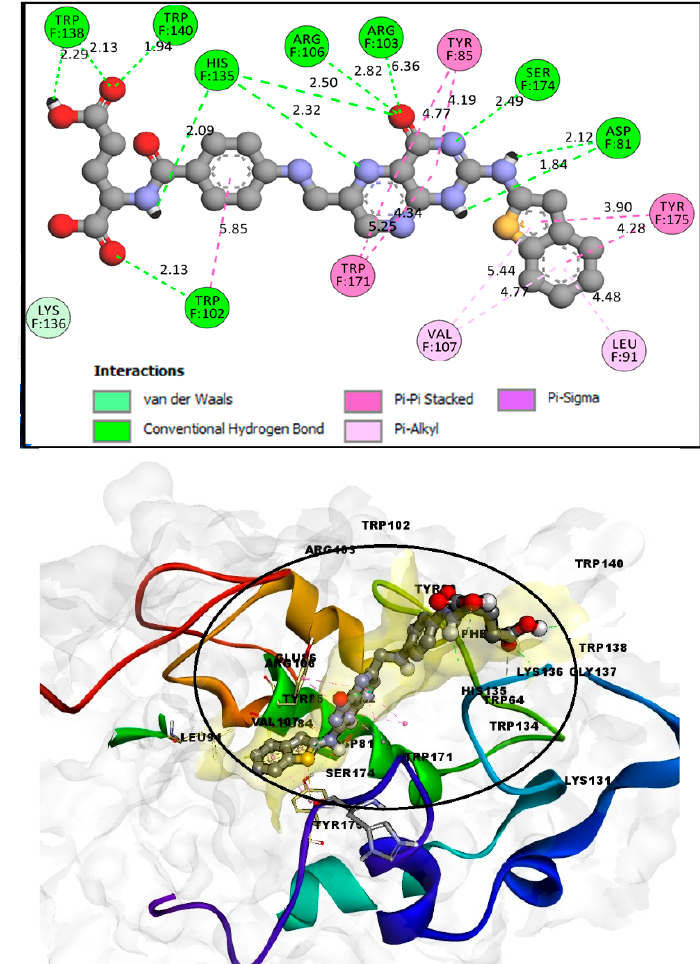
Figure 6. ( a ) Analysis model of the FOL08 (Gray C, red O, yellow S, and blue N) docked with FR α (PDB ID: 4LRH) presented as solid surface rendering. ( b ) The 2D binding-site interaction between FOL08 and FR α .